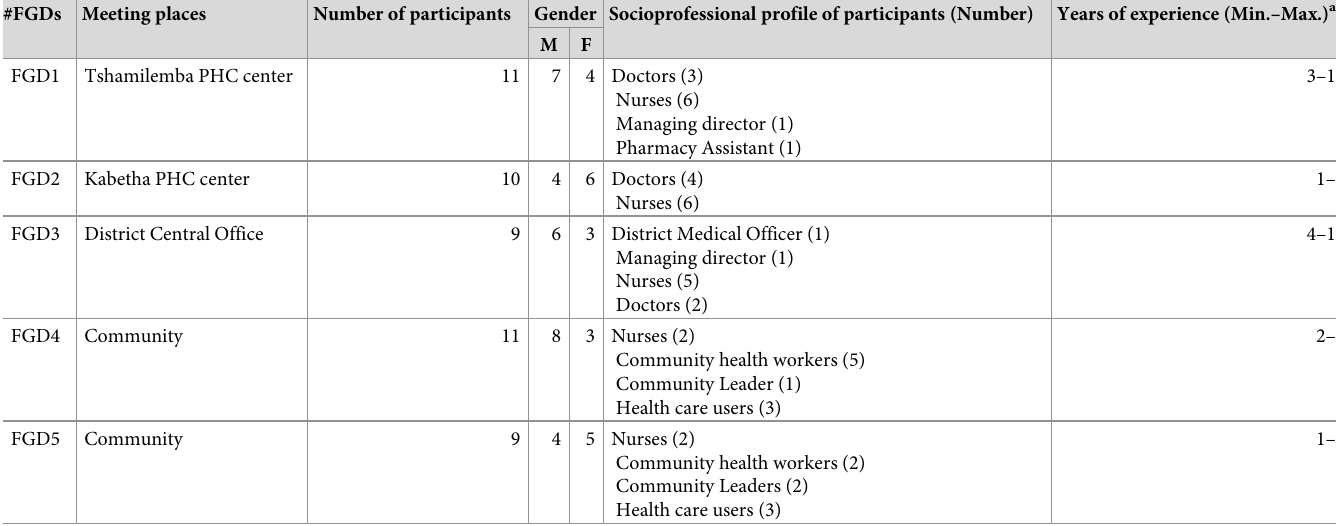
Table 2. Summary of characteristics of participants in the FGDs (N =